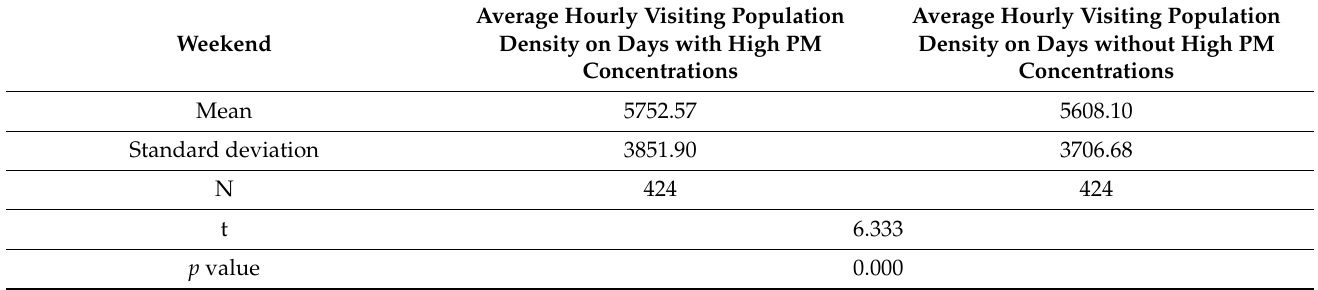
Table 4. t -test results of visiting population changes on weekends with high PM concentrations and control